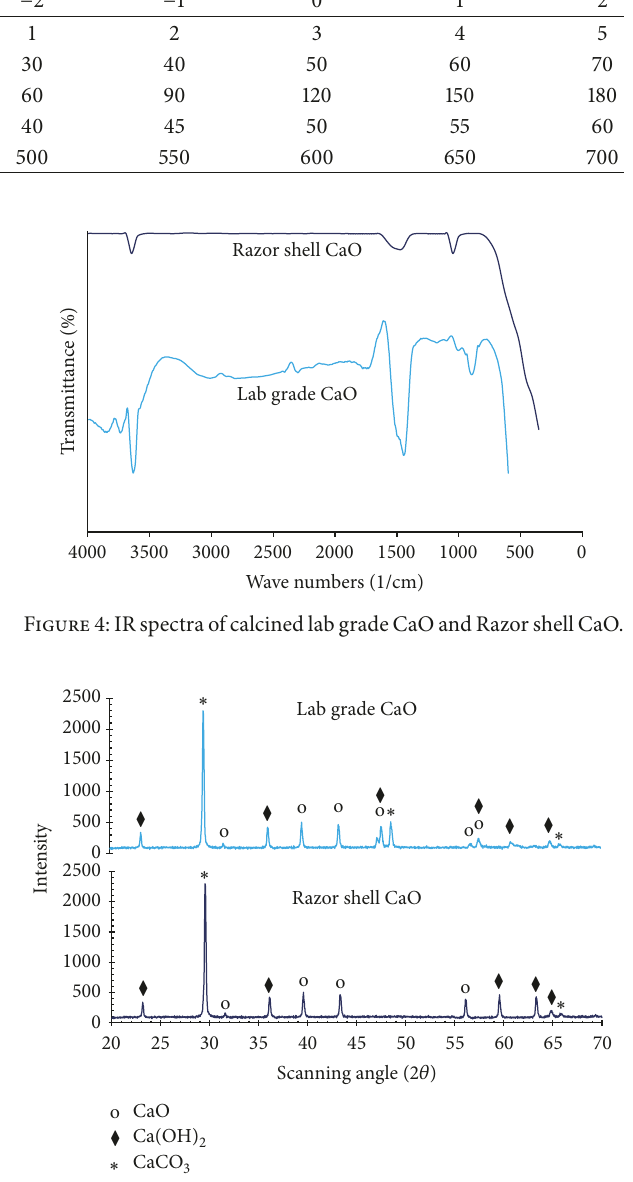
Figure 5: XRD spectral graph of analysis of calcined lab grade CaO and Razor shell